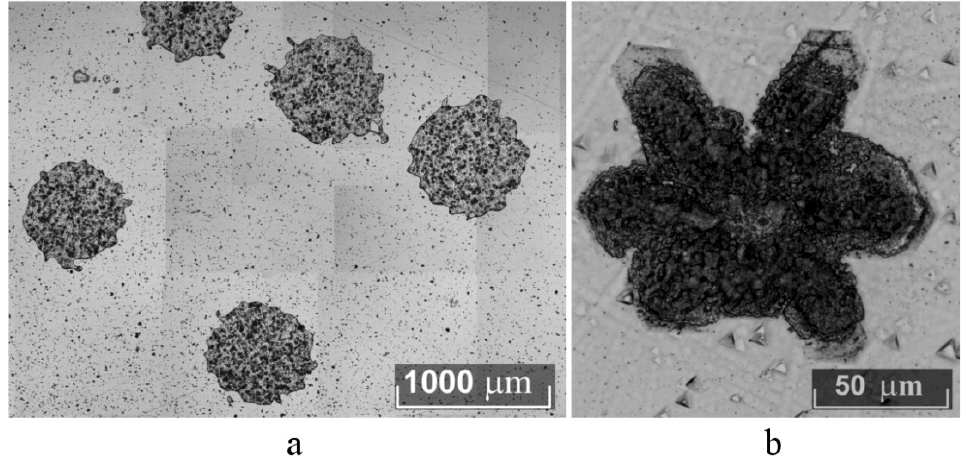
Figure A5. Isolation of the interstitial phase with incoherent boundaries on Z-cuts of crystals: ( a )– LiNbO 3 :Zn ([Zn] = 4.74 mol%); ( b )–LiNbO 3 :Mg (joint solid-phase synthesis, [MgO] = 5.6 mol% in the melt).